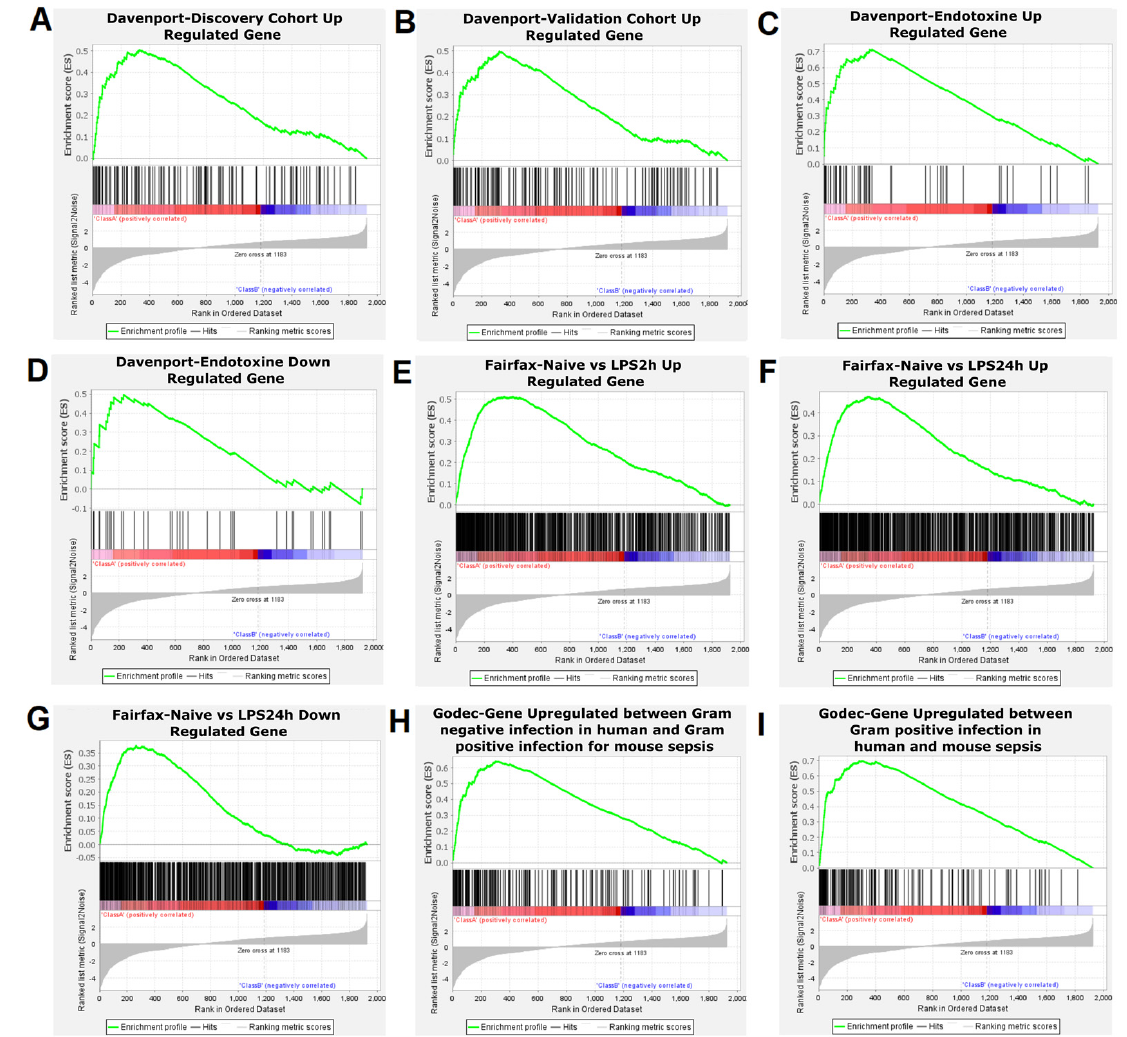
Figure 6. Gene set enrichment analysis (GSEA)-enrichment plots of comparison of our list of mouse differentially expressed genes with significant gene sets identified in three different papers. ( A ) Genes upregulated in the discovery cohort. ( B ) Genes upregulated in the validation cohort. ( C ) Genes upregulated in the endotoxin group (108 individuals from the discovery cohort with an immunosuppressed phenotype that included features of endotoxin tolerance). ( D ) Genes downregulated in the endotoxin group [26]. ( E ) Genes upregulated in 2 h LPS stimulated monocytes compared to naive monocytes. ( F ) Genes upregulated in 24 h LPS stimulate monocytes compared to naive monocytes. ( G ) Genes down regulated in 24 h LPS stimulated monocytes compared to 2 h LPS stimulated monocytes [27]. ( H ) Genes upregulated during Gram-negative infection in human and GRAM positive infection in mouse (GSE19668). ( I ) Genes upregulated in Gram-positive infection in human (GSE9960) or mouse (GSE19668) [28].